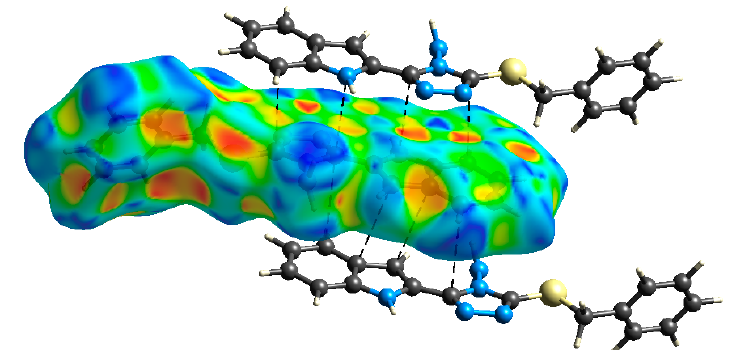
Figure 5. Shape index map showing the shortest π - π interactions. Table 3. Contact distances of the most significant π - π interactions.